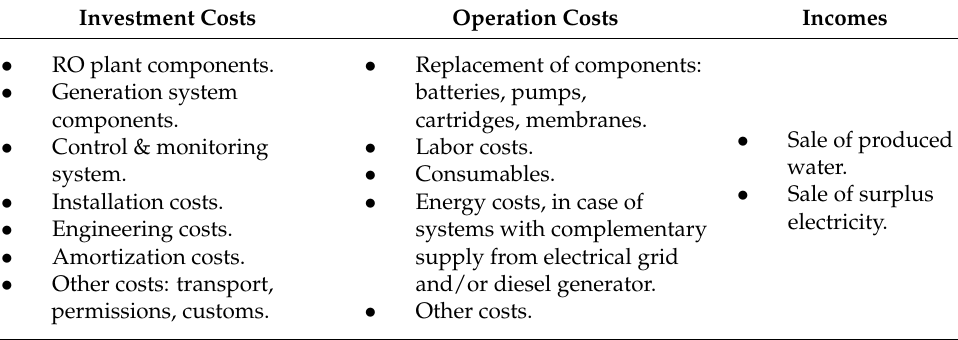
Table 13. Data to calculate the economic balance of an RE desalination